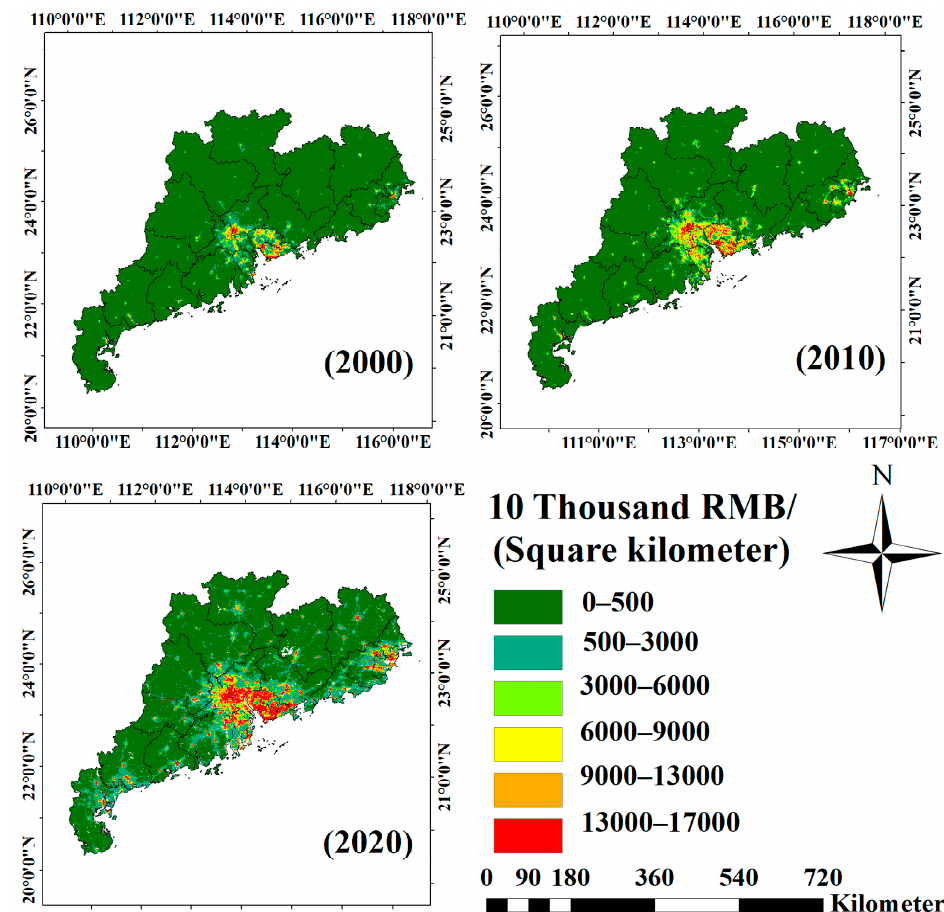
Figure 7. Spatial distribution of GDP density in 2000, 2010, and 2020.